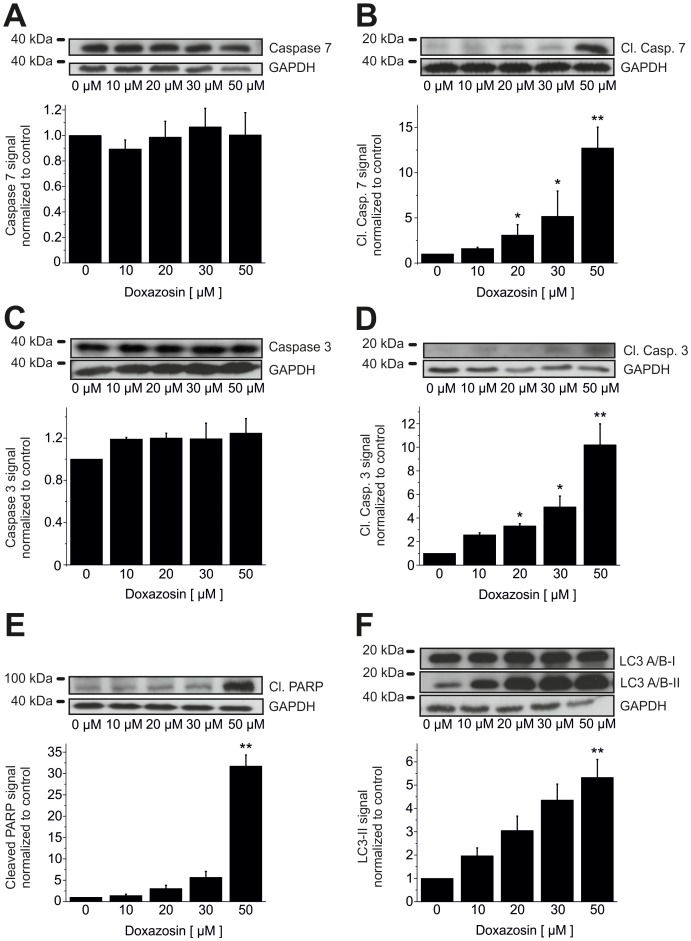
Downstream signaling in doxazosin-induced apoptosis.Doxazosin treatment induced cleavage of effector caspases 7 (B) and 3 (D), associated with unaltered expression of pre-processed caspase 3 and 7 levels in LNT-229 cells (A, C). (E) Enhanced cleavage (inactivation) of poly-ADP-ribose-polymerase (PARP) was observed with increasing concentrations of doxazosin, representing a characteristic apoptotic step. (F) Autophagy-associated phagocytosis of dead cells is indicated by increased levels of the lower migrating form of microtubule-associated protein 1 light chain 3 (LC3). Typical Western blots and mean (± SEM) optical densities normalized to drug-free conditions are shown (n = 3 independent assays; *p<0.05; **p<0.01; GAPDH, glyceraldehyde-3-phosphate dehydrogenase).